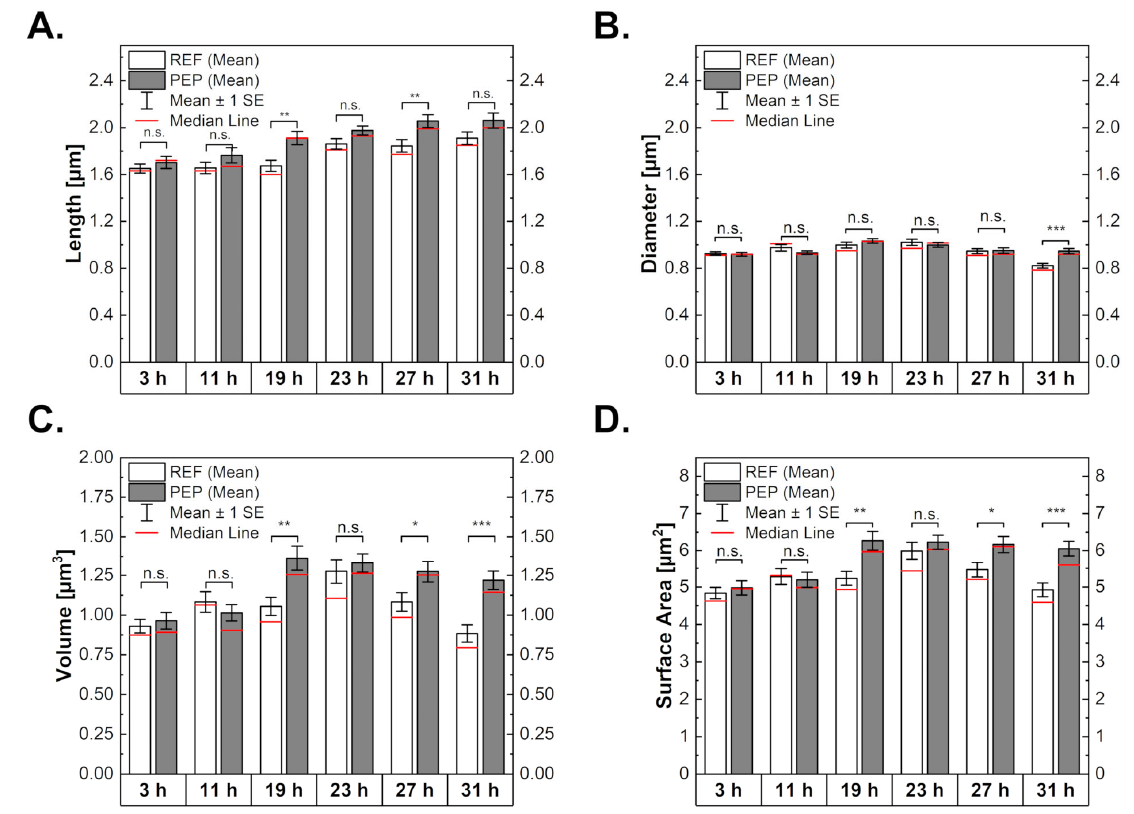
Figure 4. Morphological parameters of bacterial cells for reference (white bars) and peptide-producing cells (grey bars). The figure shows measured lengths ( A ), diameters ( B ), and calculated volumes ( C ), as well as surface areas ( D ). The number of measured cells over 3 to 31 h for the reference sample was 82, 45, 42, 44, 55, and 54, and for the peptide-producing one, 63, 70, 60, 92, 75, and 74. N.s. indicates non-statistically significant differences, * significance with p -value < 0.05, ** with p -value < 0.01 and *** with p -value < 0.001.